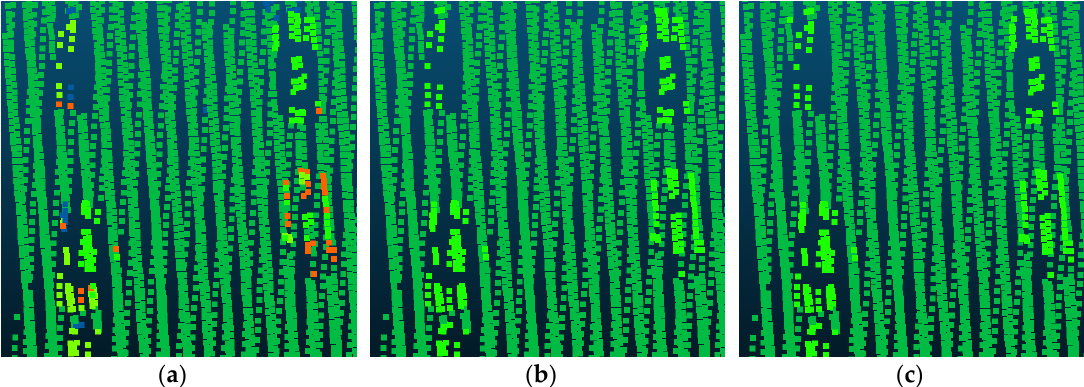
Figure 9. The detailed improvement of car classification. ( a ) The Point_S result. ( b ) The SegT_M result. ( c ) The ground truth.